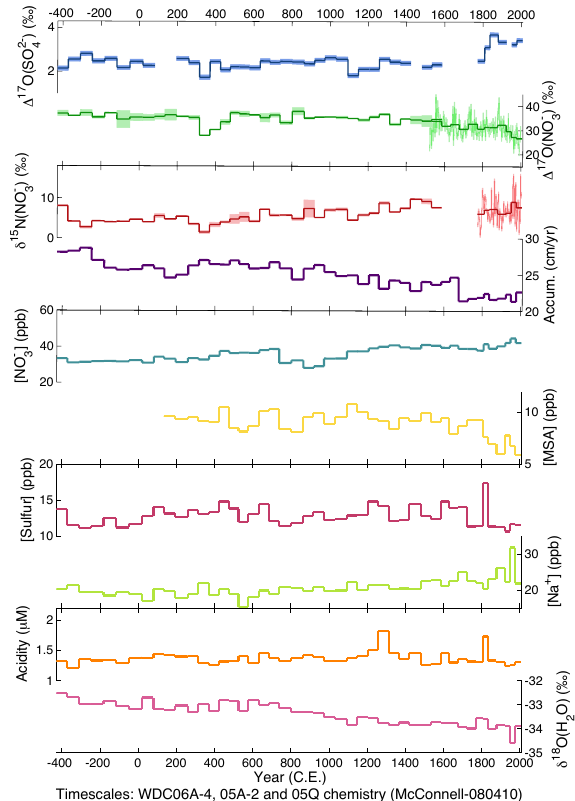
Figure 3. Low-resolution sulfate and nitrate isotopes compared to measurements of accumulation rate, nitrate concentration, MSA concentration, sulfur concentration, sodium concentration, acidity, and δ 18 O ( H 2 O ) from the WDC06A core (except for nssSO 42 − , from WDC05Q) averaged to the resolution of the sulfate isotope